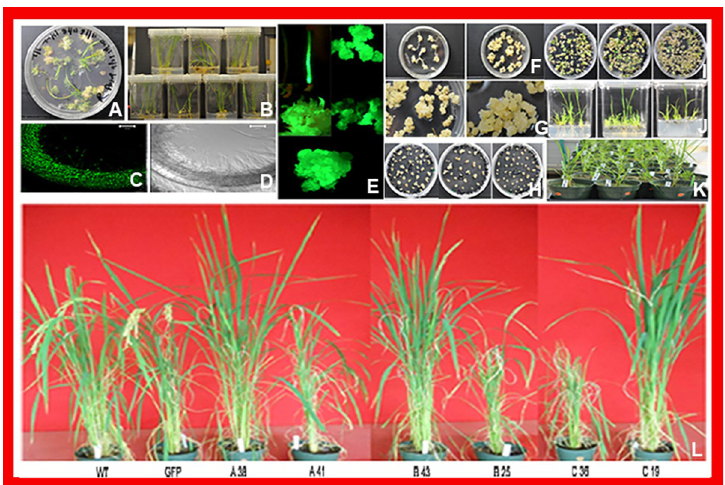
Fig 4. Transgenic plants (T0) regenerated from Agrobacterium –mediated genetic transformation of rice calli having 1, 3, 4 & 5 month old using circadian clock gene constructs A, B, & C. (A) Number of transgenic plants regenerated. (B) Percentage of transgenic plants